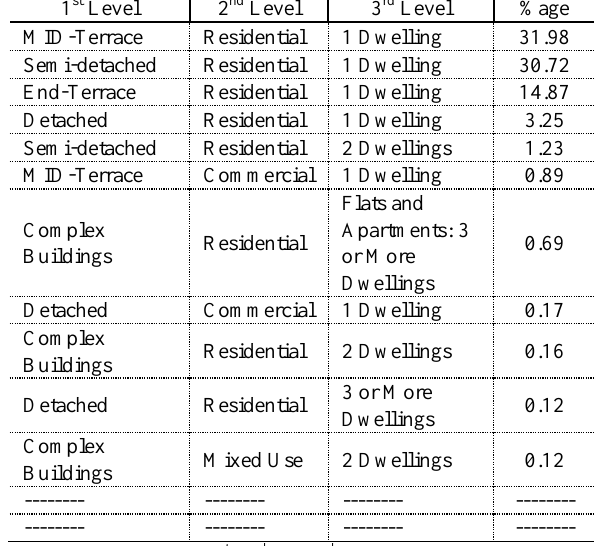
Table 10: Results for 1 st , 2 nd and 3 rd level building